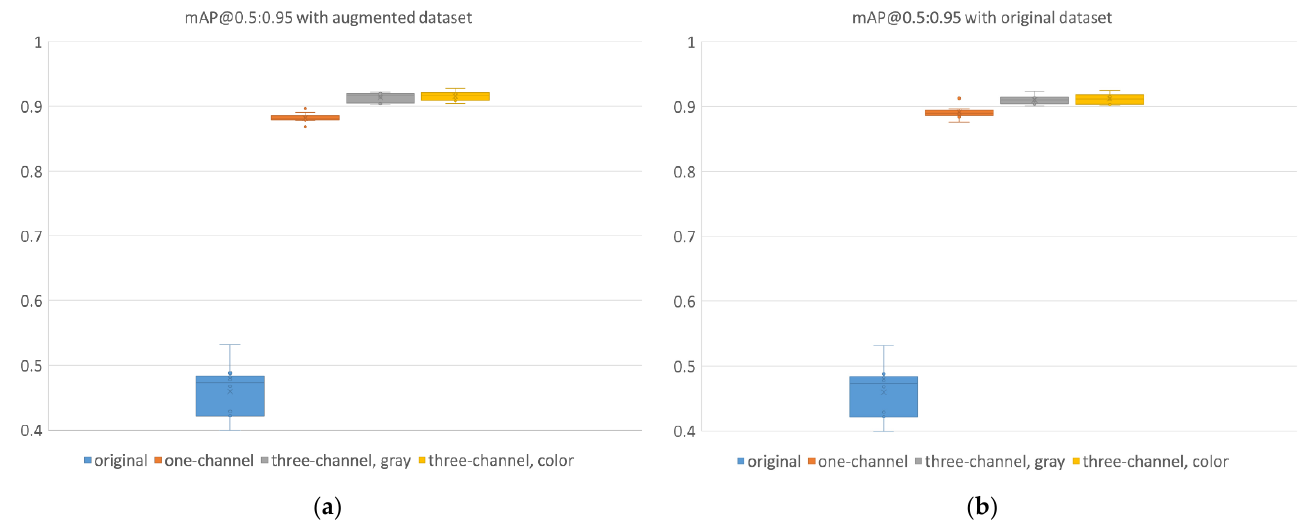
Figure 14. Boxplots of validation mAP@0.5:0.95 with YOLOv4: ( a ) results validate with the augmented dataset; ( b ) results validate with the original dataset.